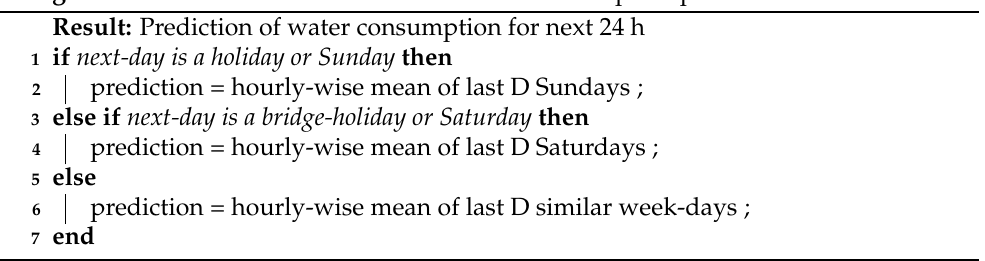
Algorithm 1: Pseudocode for the naïve water consumption prediction model Result: Prediction of water consumption for next 24